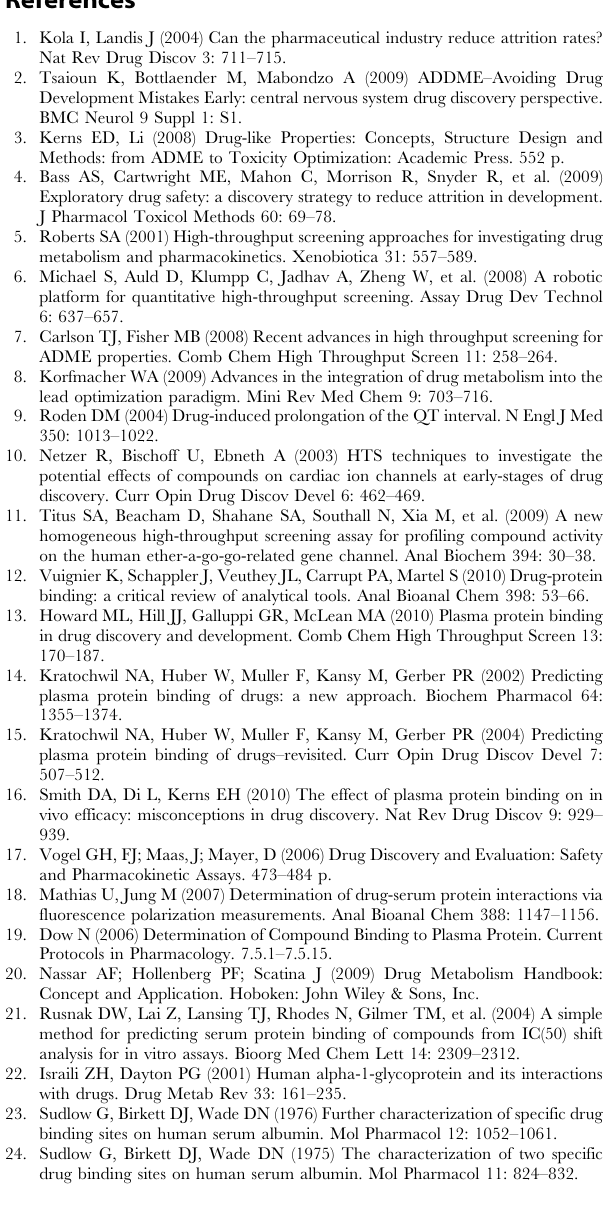
Figure S3 Lack of dependence of IC 50 values for validation set compounds on the method of assay